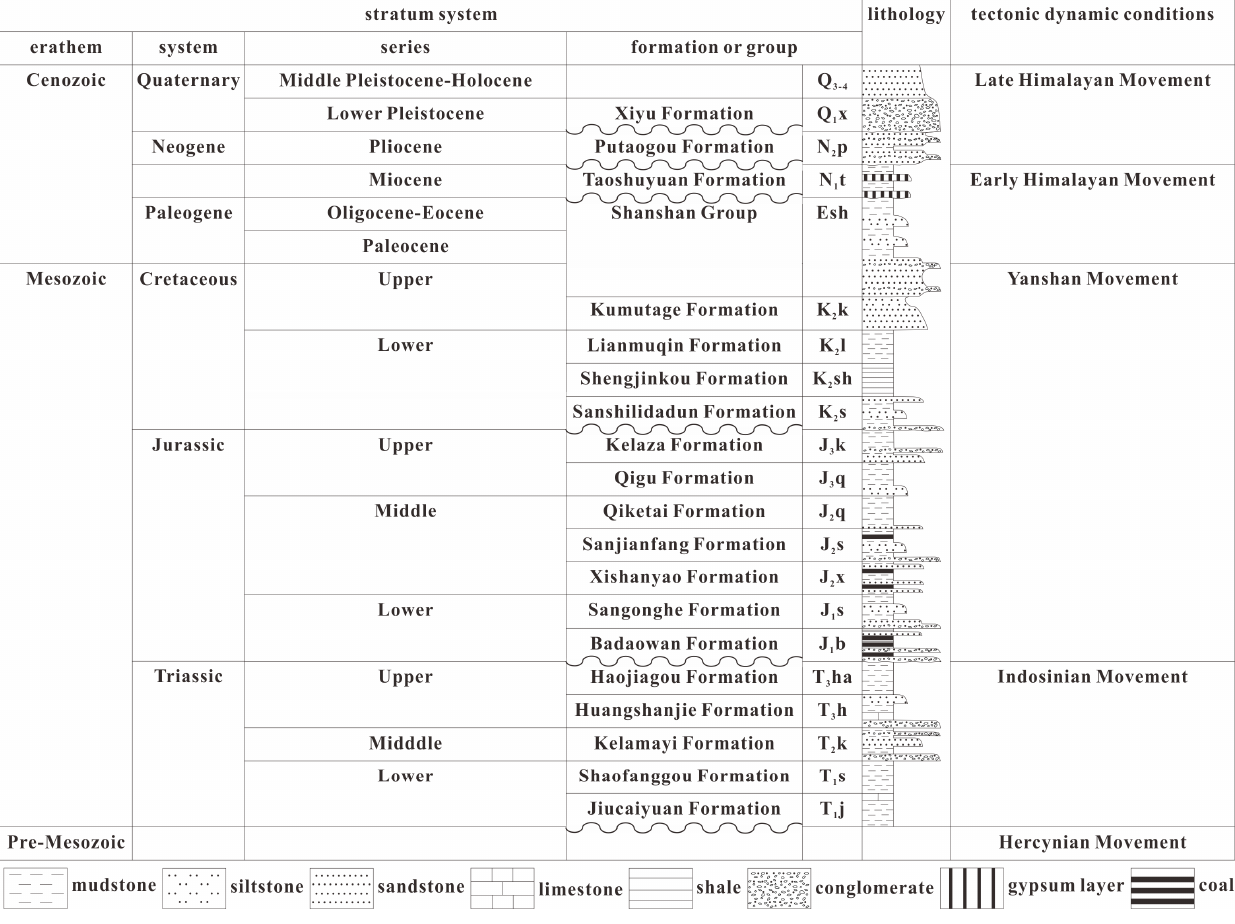
Figure 4. Schematic regional stratigraphic chart illustrating deposition sequences of the FTB in the Turpan Basin (modified from Shao et al. [96] and references therein).